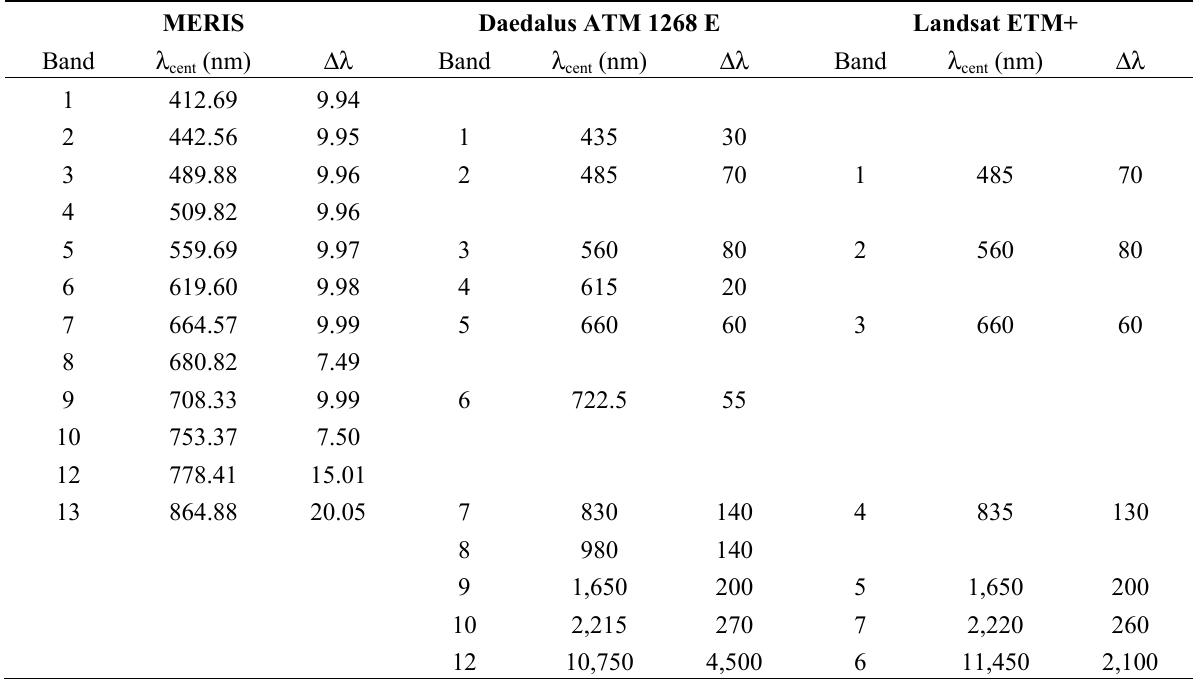
Table 2. Daedalus ATM HR spectral channels and related MERIS and ETM+